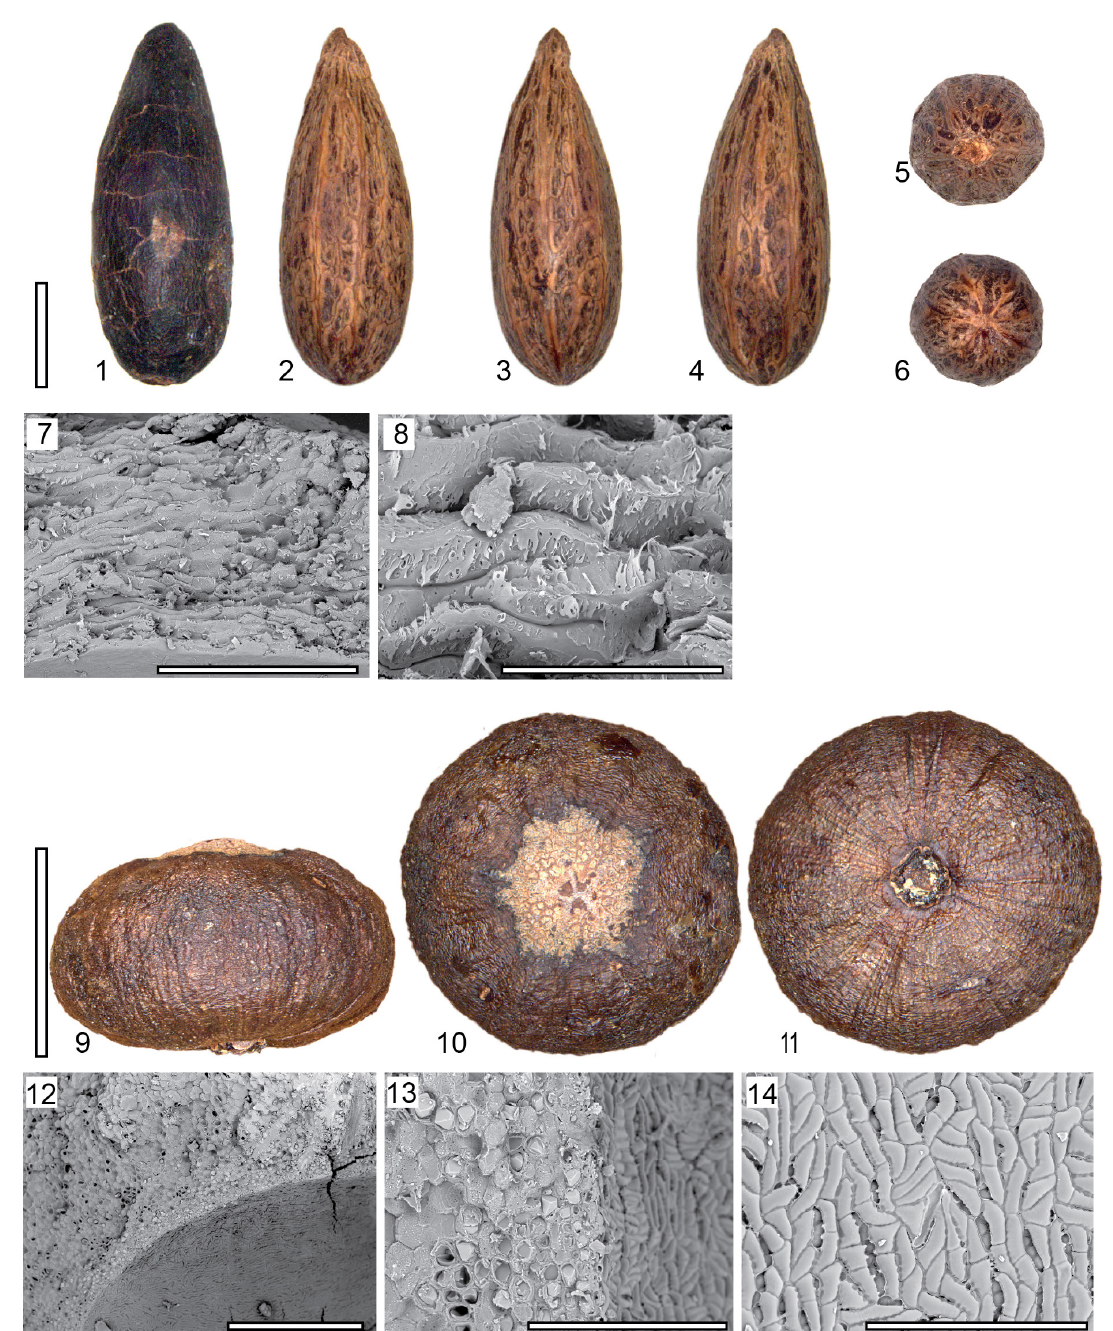
Fig. 36. Fruits of Metteniusaceae H.Karst. ex Schnizl. and Oncothecaceae Kobuski ex Airy Shaw. 1 – 8 . Platea parvifolia Merr.& Chun ( W.T. Tsang 27299 ). 1 . Dried fruit, lateral view. 2 – 6 . Endocarp. 2 . Lateral view showing the mounds. 3 . Dorsal view. 4 . Opposite lateral view. 5 . Apical view. 6 . Basal view. 7 . SEM image of the endocarp wall in transverse section. 8 . Detail showing the endocarp cell walls and their organization. – 9 – 14 . Oncotheca balansae Baill. ( H.S. Mackee 37671 ). 9 – 11 . Dried fruit 9 . Lateral view. 10 . Apical view. 11 . Basal view. 12 . SEM image of the outer and inner endocarp wall. 13 . SEM image of the inner endocarp wall showing prismatic crystal. 14 . SEM image of the locule surface lined by elongate cells. Images taken from Del Rio (2018). Scale bars: 1–6, 9–11 = 10 mm; 12= 1 mm; 7 = 500 μm; 13 = 300 μm; 14 = 200 μm; 8 = 100